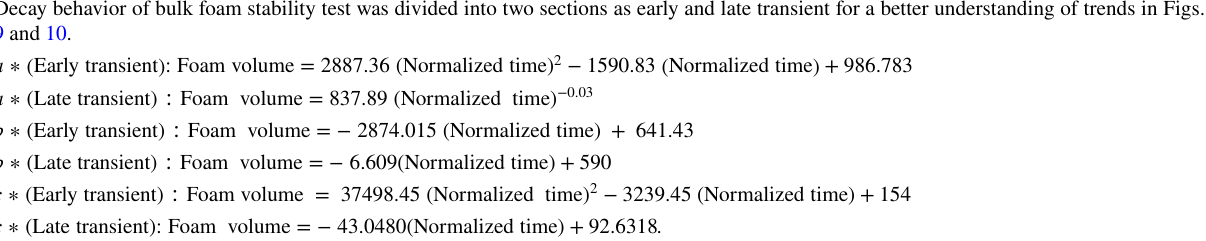
Fig. 5 The clustered column charts are displaying the results of the “bulk foam stability test” for the three surfactants. The chart on the left is for foam strength attributes, whereas the chart on the right is for the foam stability